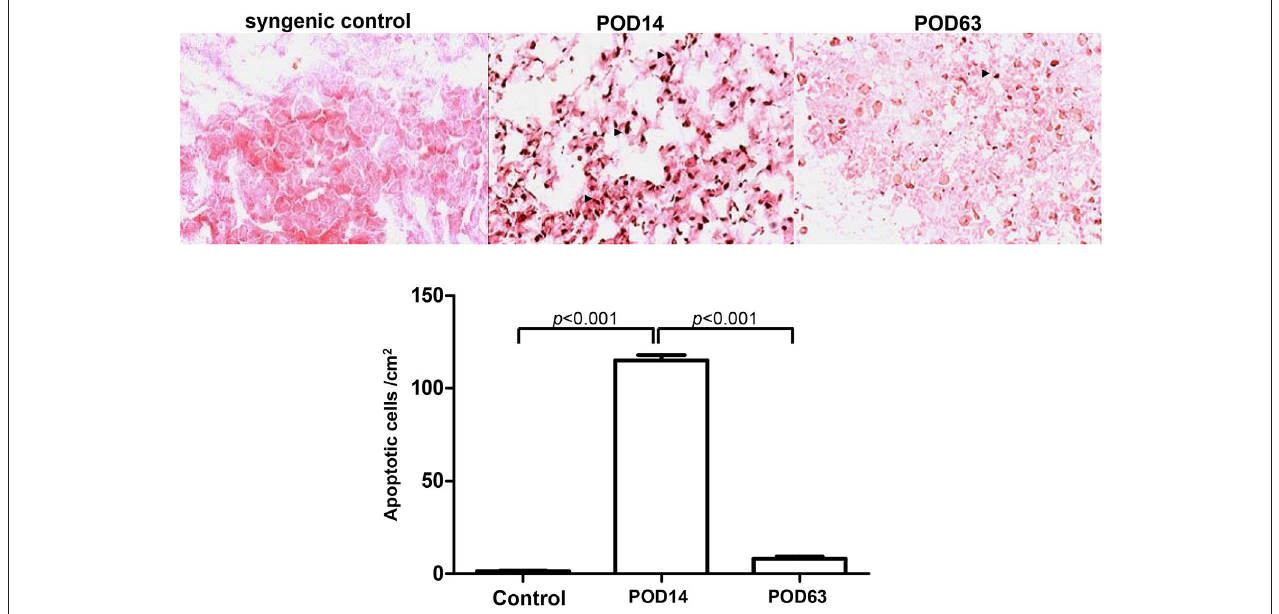
FIGURE 1 | Histological analysis of cellular apoptosis in rat liver tissues on syngenic control, POD14 and POD63. The apoptotic signal was quantified and indicated by the bar chart.